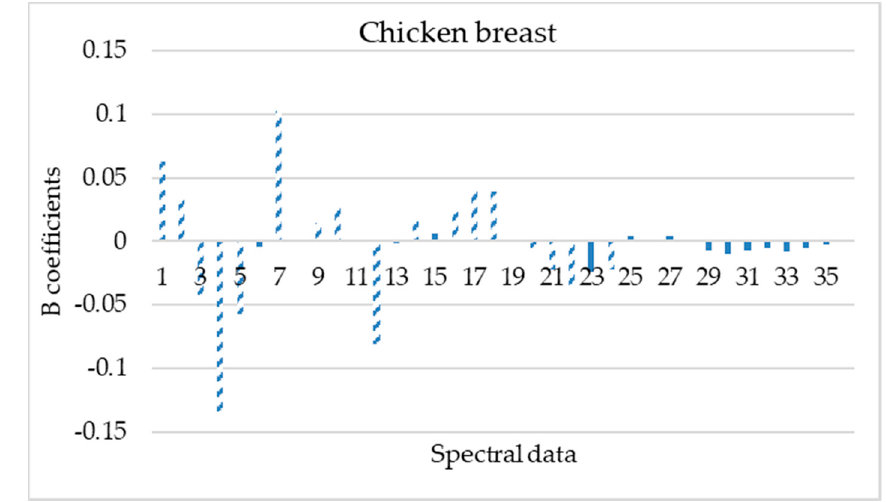
Figure 4. Spectral data (mean and standard deviation) influence (b coefficients) on PLS-R model construction for chicken breast samples. Dashed bars represent data that influenced more the model